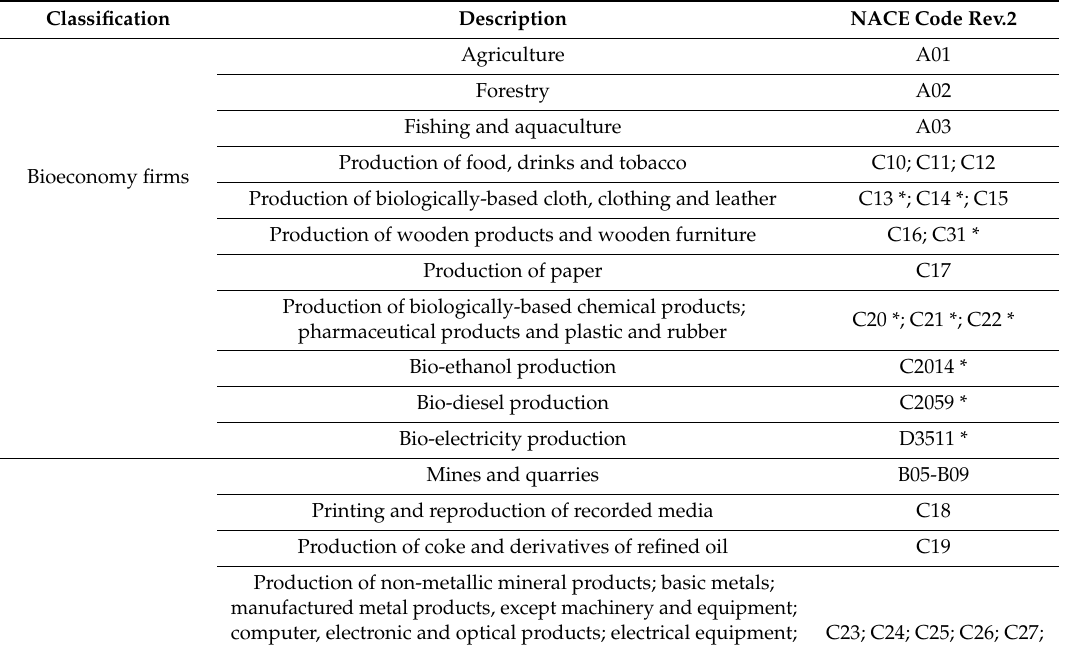
Table A1. Sector classification: National Classification of Economic Activities-NACE